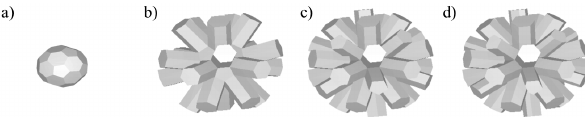
Fig. 7. From left to right: (a) a core of 3B, (b) 3B with 20 regular hexagonal columns, (c) 3B with 20 regular hexagonal and 12 pentagonal columns, and (d) 3B with 20 regular and 12 irregular hexagonal columns.